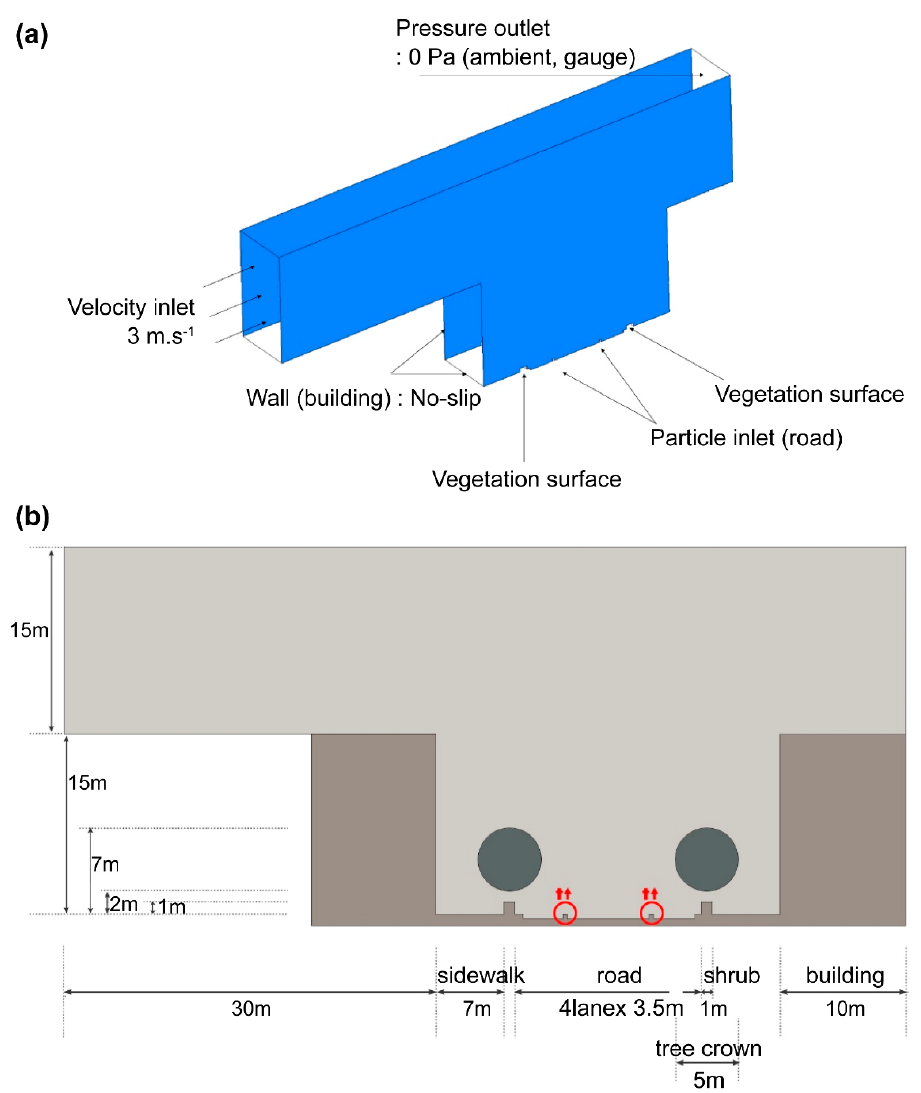
Figure 1. Model geometry example for F3: ( a ) boundary conditions and ( b ) model layout and conditions. The red arrows indicate PM generation locations (Particle inlet).